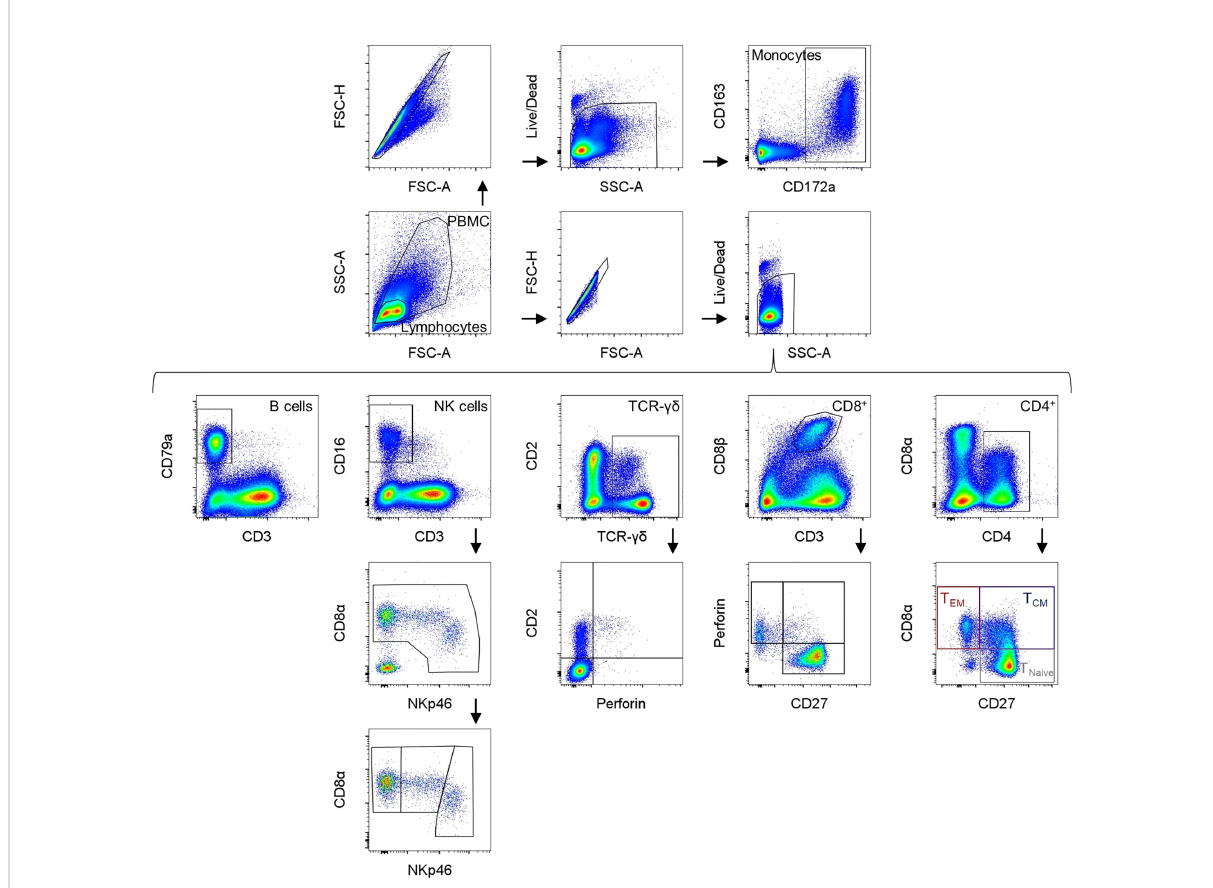
FIGURE 1 Gating strategies for the different immune cell subsets (a male pig, aged 18 weeks is shown as a representative animal). In the upper row, identi fi cation of monocytes is presented using CD172a and CD163 expression. Below, the gating strategy for the different lymphocyte subpopulations is shown. B cells were determined as CD3 - CD79a + . NK cells were characterized as CD3 - CD8 a + CD16 + and further divided into NKp46 - , NKp46 + , and NKp46 high NK cells. TCR- gd + T cells can be divided into three phenotypes: CD2 - perforin - and CD2 + cells that can either be negative or positive for perforin expression (no clear CD2 - perforin + gd + T cells were found). Cytolytic T lymphocytes (CTLs) are de fi ned as CD3 + CD8 b + and can be divided into different phenotypes via their CD27 and perforin expression. CD4 was used as a pan marker for T helper cells and CD8 a and CD27 expression can be used to differentiate between naive CD4 + CD8 a - CD27 + (T Naive ) T cells, CD4 + CD8 a + CD27 + activated and central (T CM ) and CD4 + CD8 a + CD27 - effector memory (T EM ) T